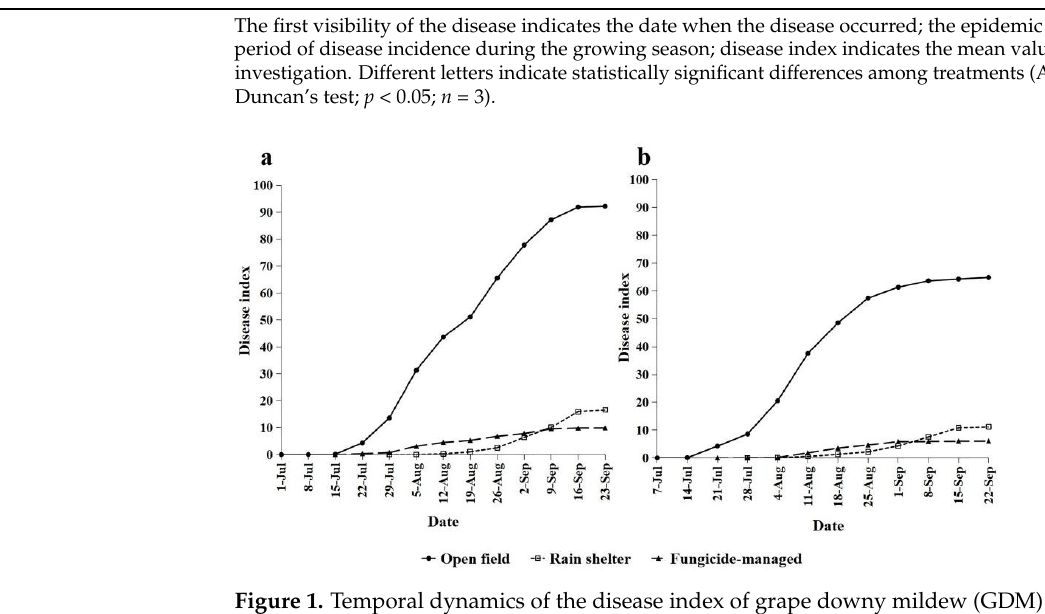
Figure 1. Temporal dynamics of the disease index of grape downy mildew (GDM) under open-field, rain-shelter, and fungicide-managed plots in Shenyang 2016 ( a ) and 2017 ( b ). Table 2. Changes in the canopy microclimate under open-field, rain-shelter, and fungicide-managed plots in Shenyang